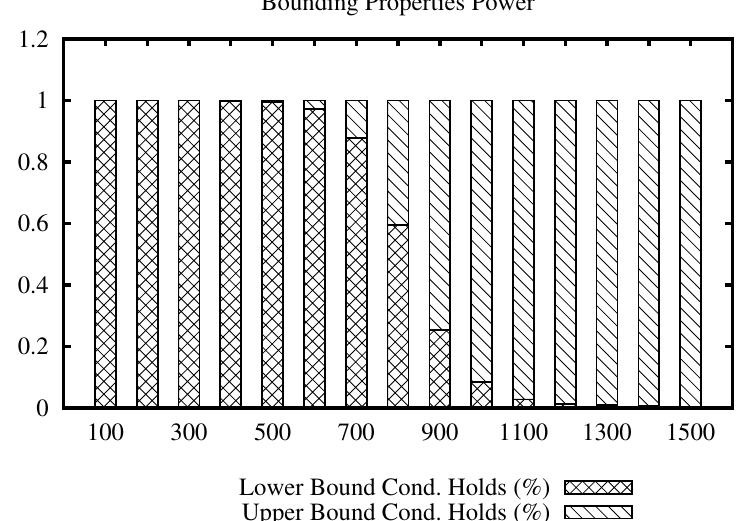
Figure 7. Percentage of filtering that each bounding property can achieve within the range of radius of the join algorithm using the ImgMedical data set with the L 1 distance function.